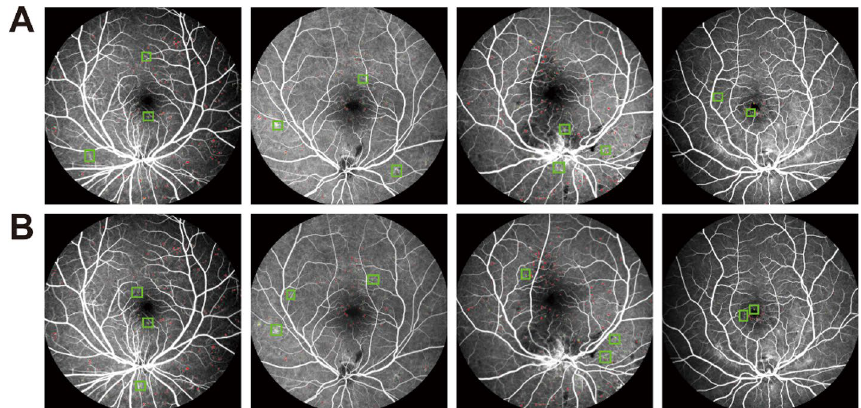
Figure 6. MA detection results by DeeplabV3+ and PSPNet. ( A ) DeeplabV3+; ( B ) PSPNet.